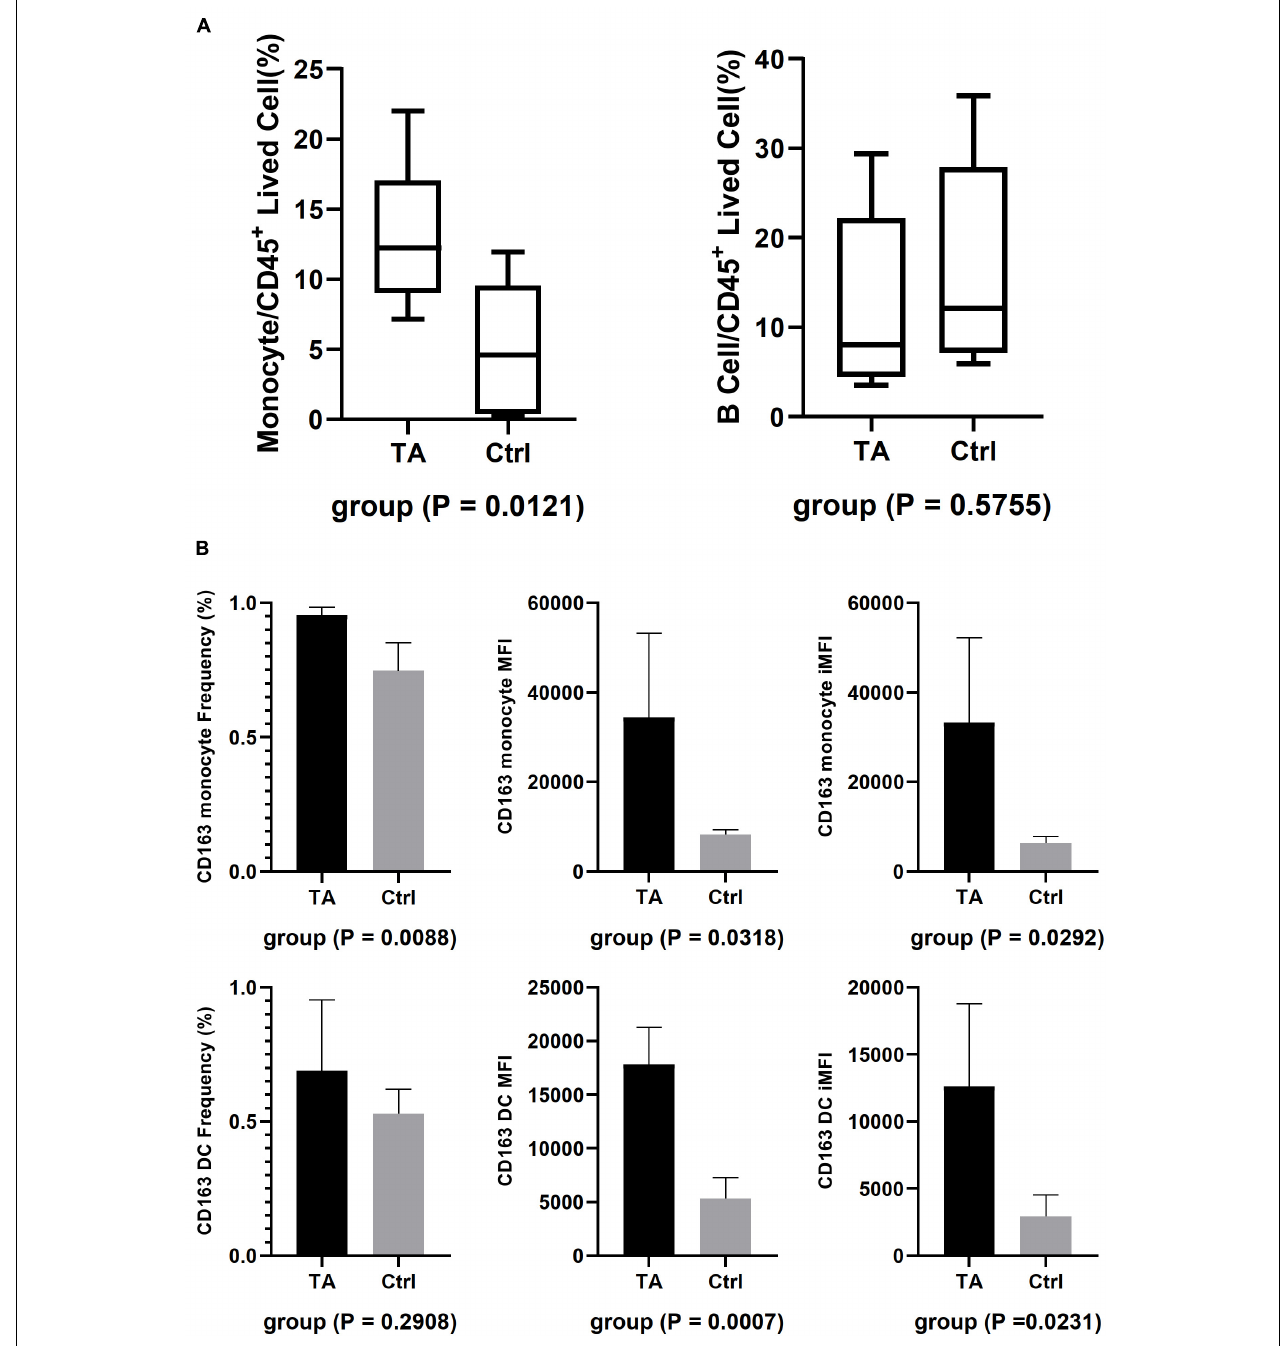
FIGURE 5 | FACS results. (A) The composition of CD14 + monocyte and B cell in TA and Ctrl group. Only CD14 + monocyte had higher composition in TA than Ctrl. (B) iMFI showed both monocytes and DC had a higher expression on their membrane in TA group.